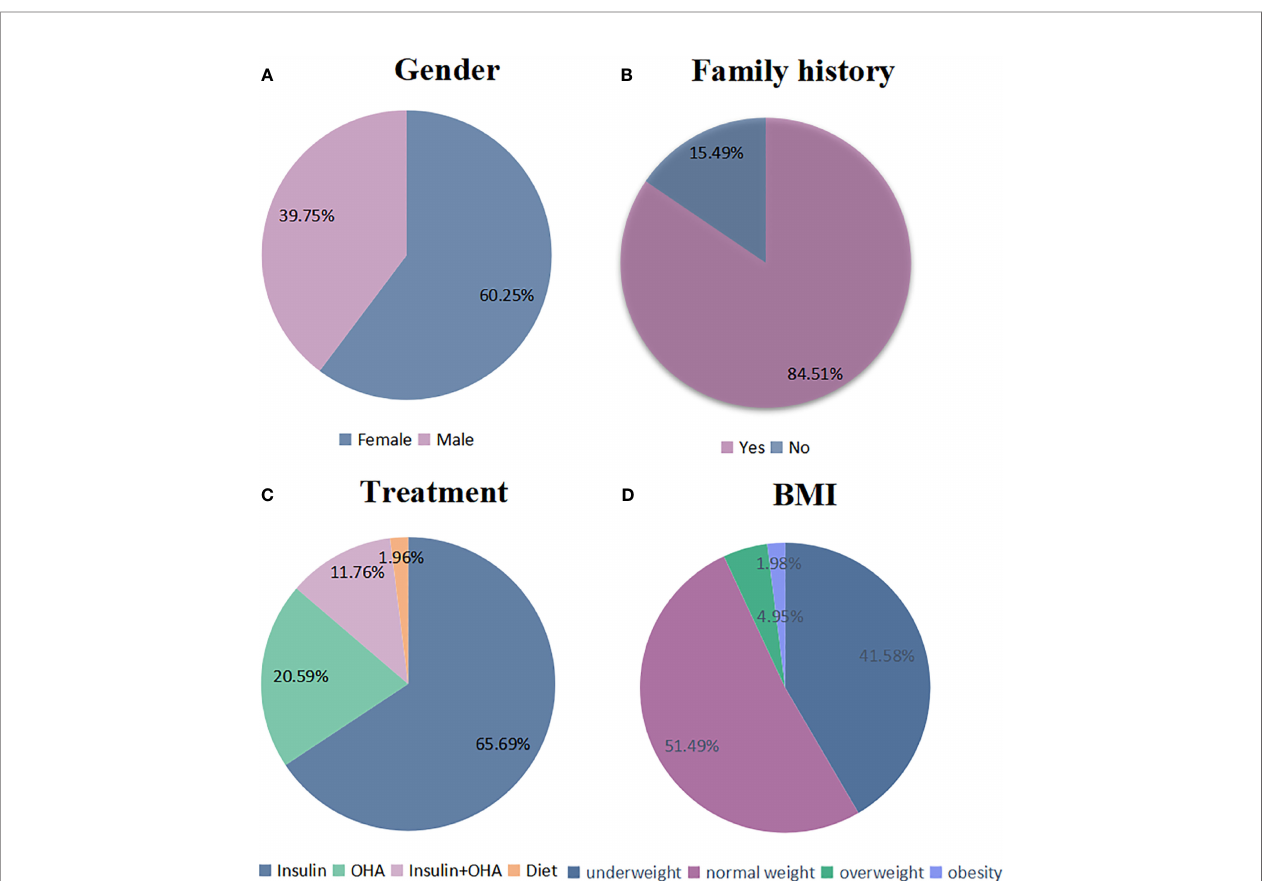
(4.97%), ptosis (2.48%). Ragged red fi bers on muscle biopsy were (23.60%) patients, and the prevalence of macular degeneration